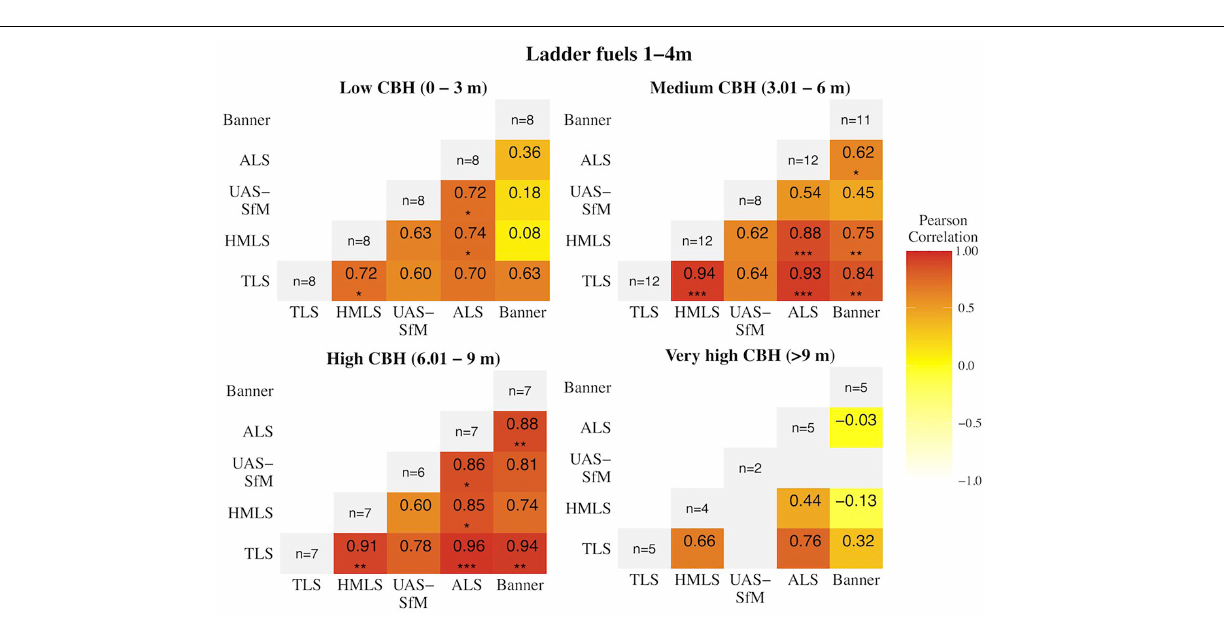
FIGURE 4 | Heatmap of Pearson correlation coefficients for ladder fuel density 1–4 m by CBH category across all methods. The CBH categories used are as follows: low (0–3 m), medium (3.01–6 m), high (6.01–9 m), and very high ( > 9 m). Significance is as follows: *** p -value ≤ 0.001, ** 0.001 > p -value ≤ 0.01, * 0.01 > p -value ≤